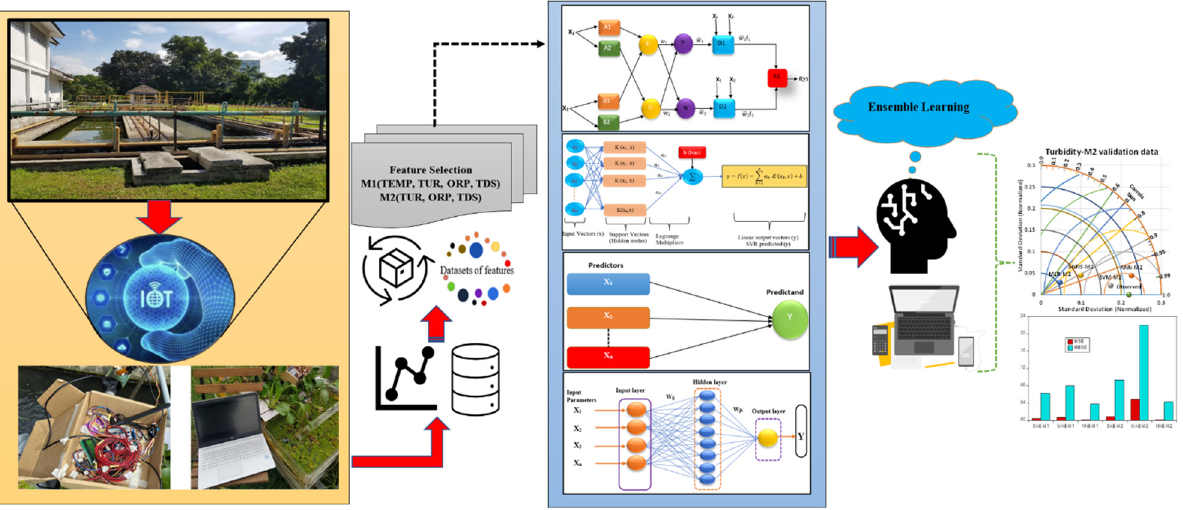
Figure 2. Proposed modeling schema and input combination. Table 1. Parameters used (influent (raw) and effluent (treated) samples).